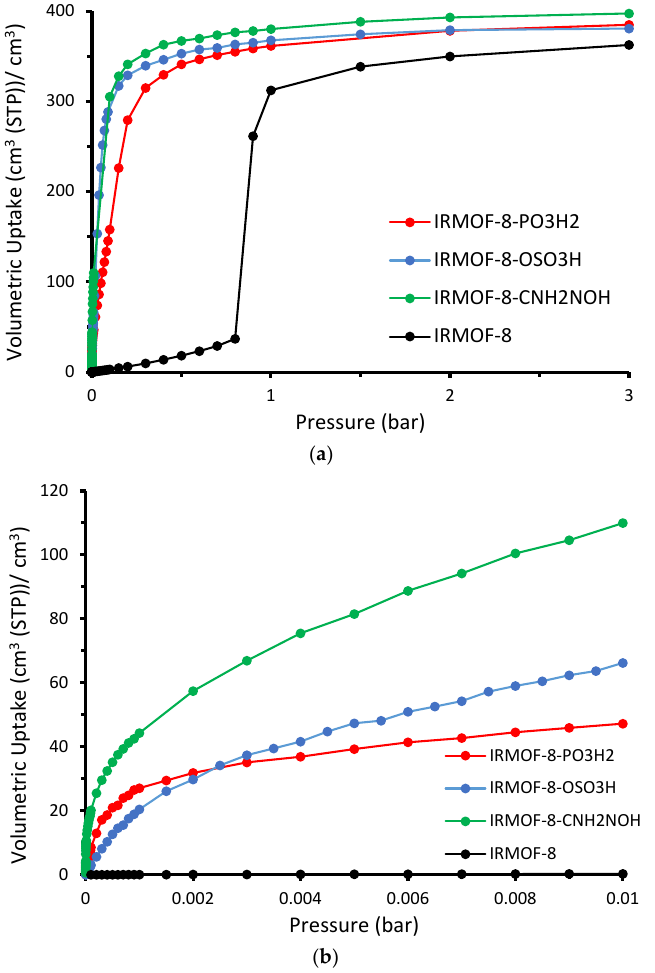
Figure 5. The absolute volumetric uptake isotherms for IRMOF–8 and IRMOF–8–n (n: –PO 3 H 2 , –OSO 3 H, and –CNH 2 NOH) at T = 298 K and pressure range from ( a ) 3 bar to ( b ) 0.01 bar.